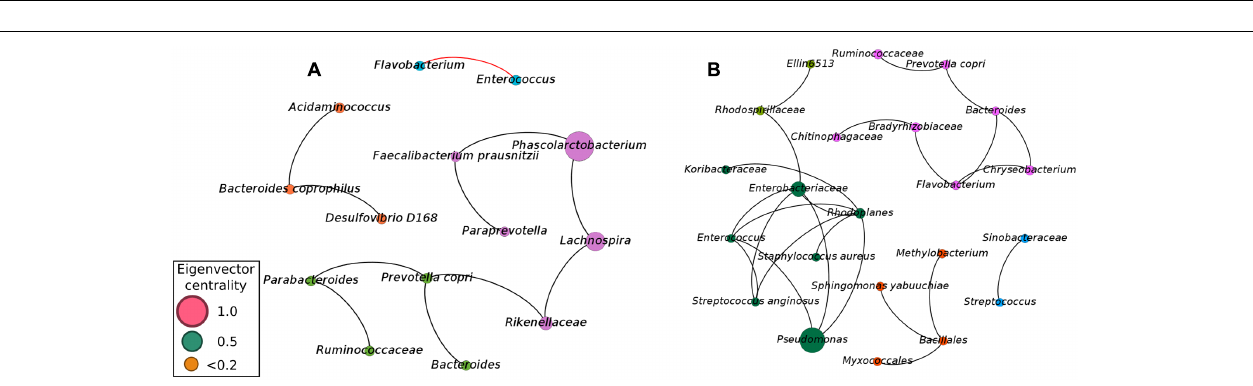
FIGURE 1 | Phylogenetic classification scheme of the microbial community found in a patient with further development of Necrotising Enterocolitis (NEC). Species identification was based in ultra-long metagenome sequences matching the NCBI taxonomy. The tree presents only microorganisms with a minimum of 10 classifications per node and a threshold quality score of 20. Branches are weighted according to the microbial abundance. The yellow circle represents the node of the Enterobacteriaceae family.